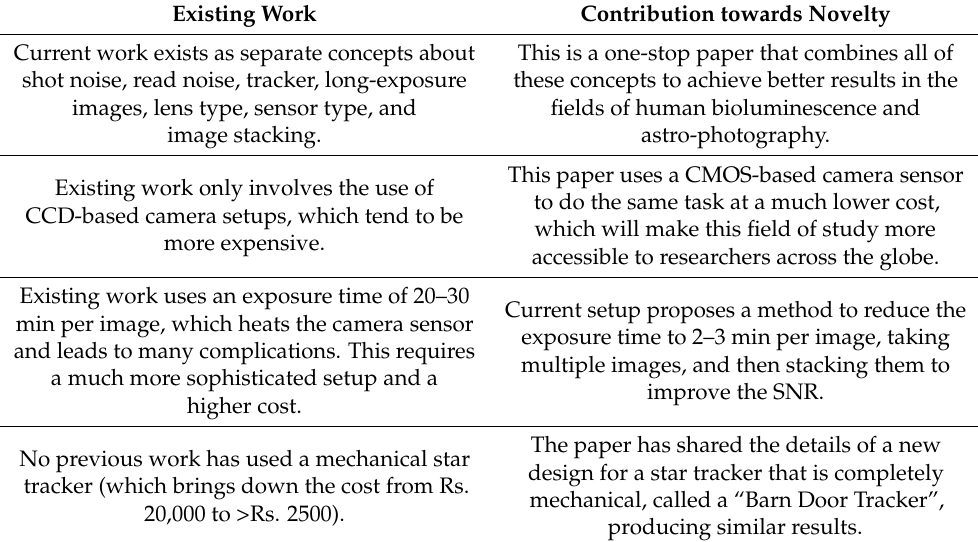
Table 4. Comparison of existing work vs. proposed